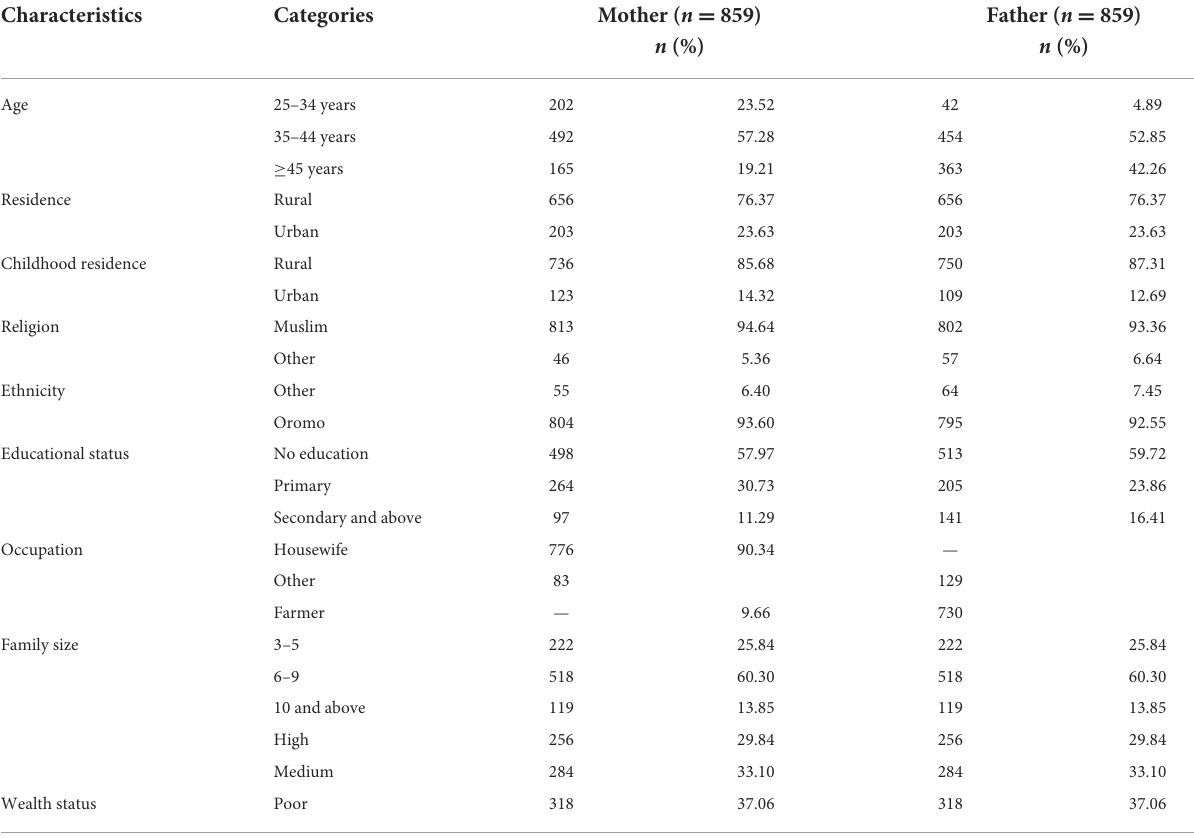
TABLE 1 Background characteristics of parents of unmarried girls living in Kersa HDSS, Eastern Ethiopia, 2019.